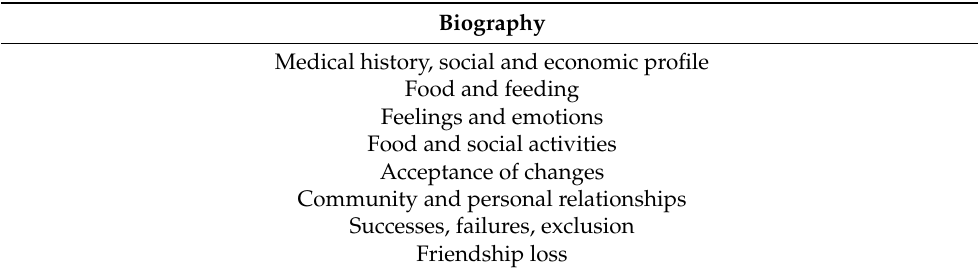
Table 2. In-depth interview guide: categories and